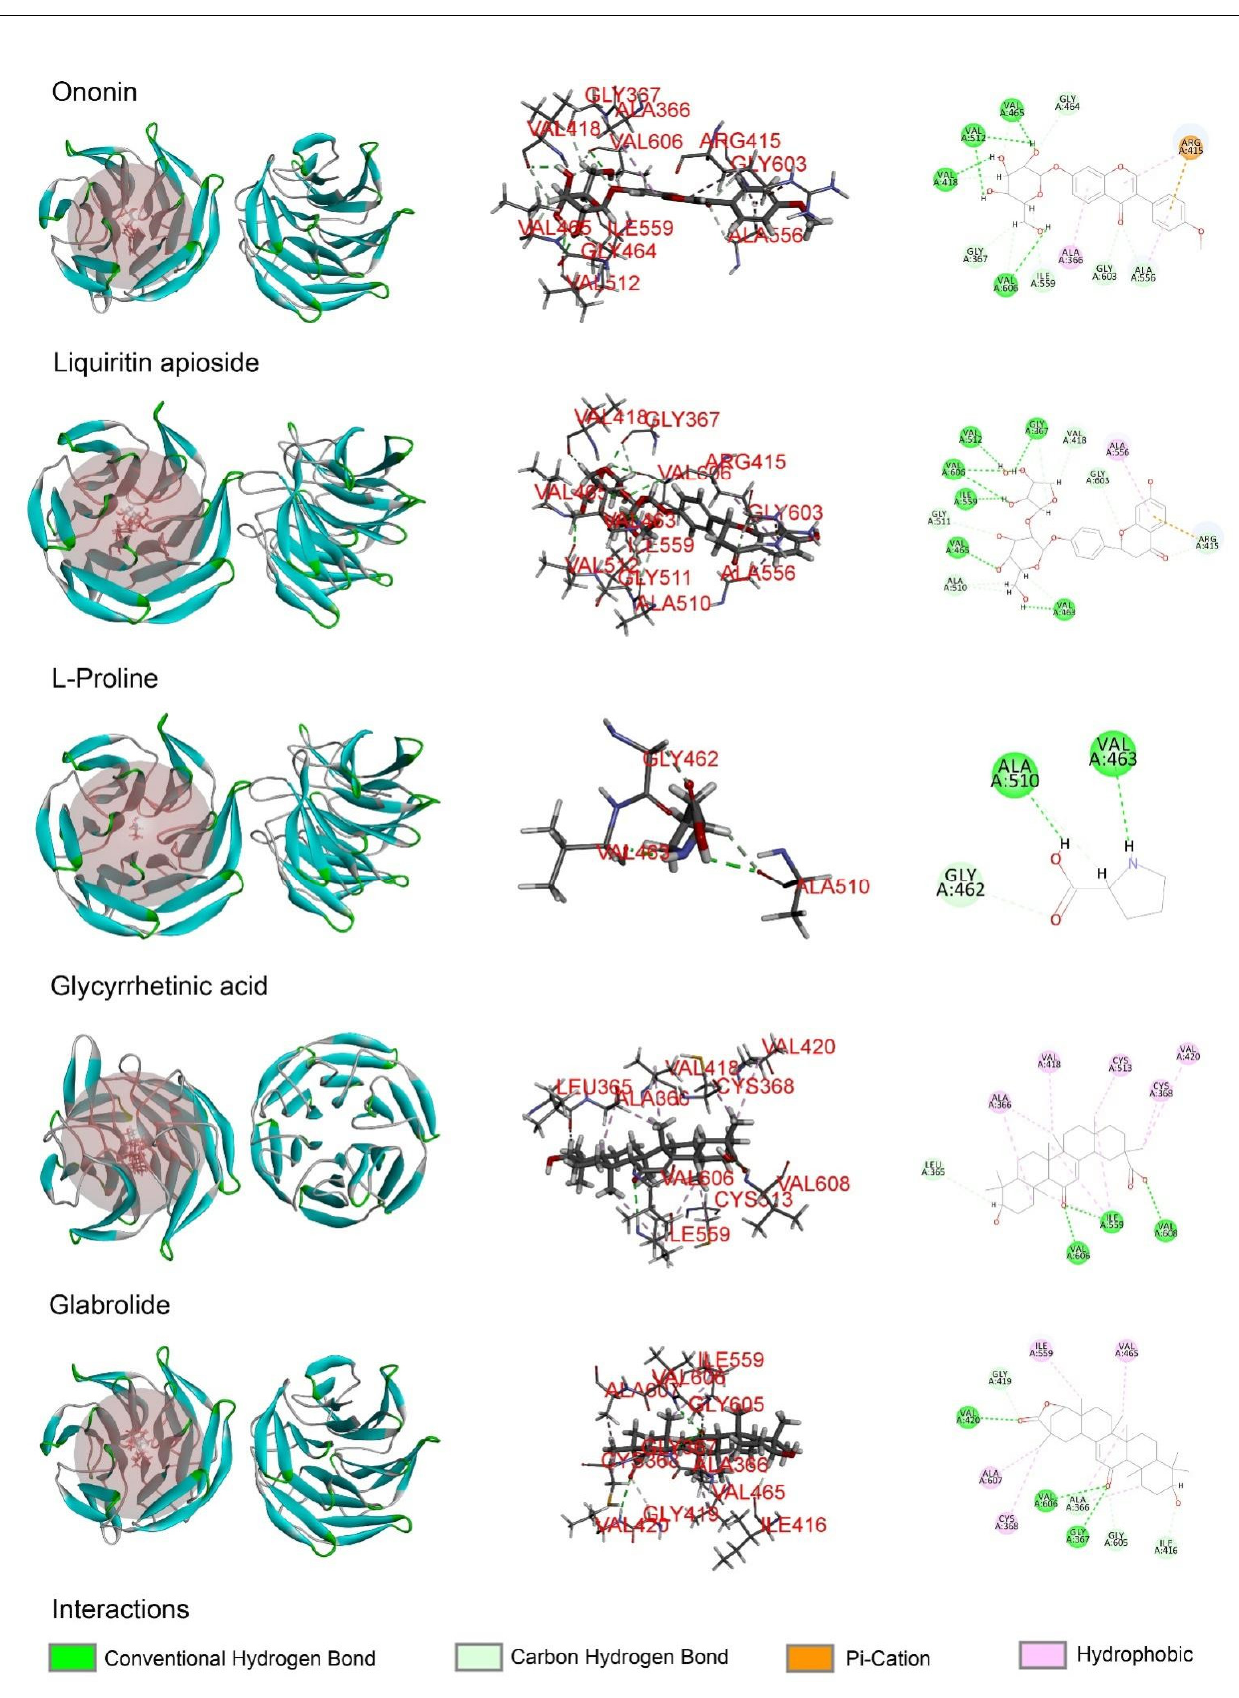
Figure 6. Docking simulation for the interaction between the main components of roasted licorice and KEAP1 (PDB: 4zy3), showing a general overview, local overview, and 2D overview.